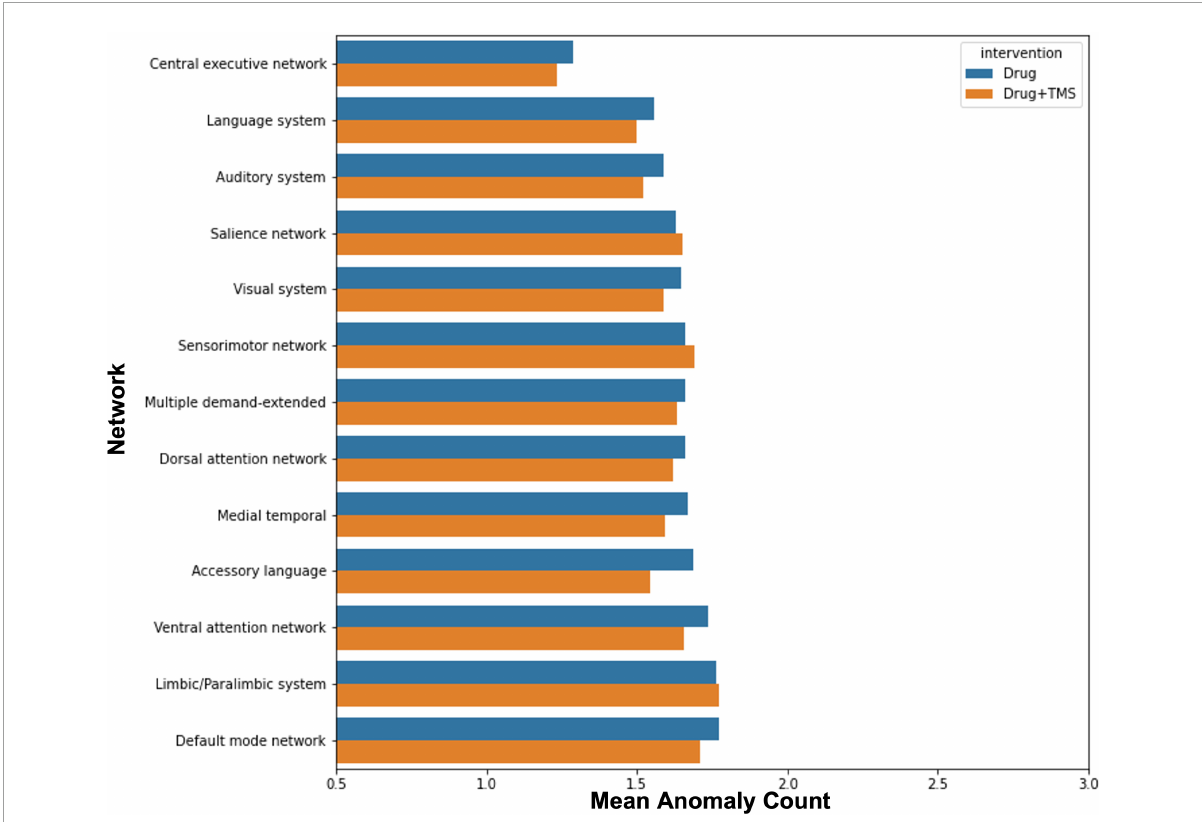
FIGURE3 Effect of intervention on anomalies. The graph demonstrates the mean change in anomaly count by network for participants who received pharmacotherapy alone, and those who received pharmacotherapy and